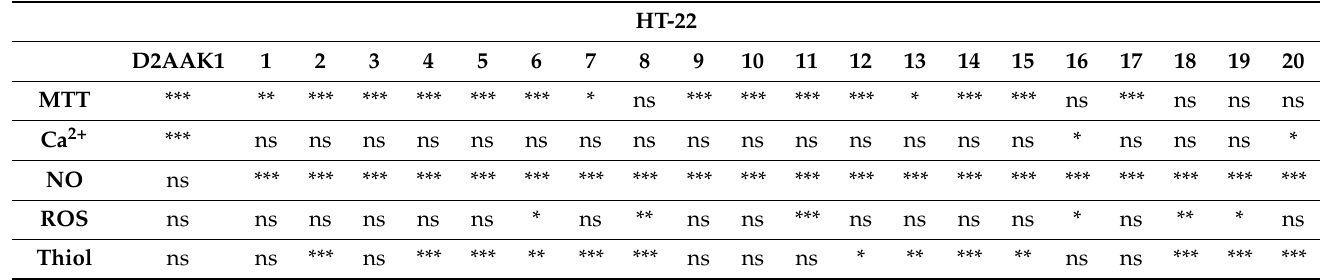
Table 1. Summary of statistical differences of all experimental sets. Statistically significant results